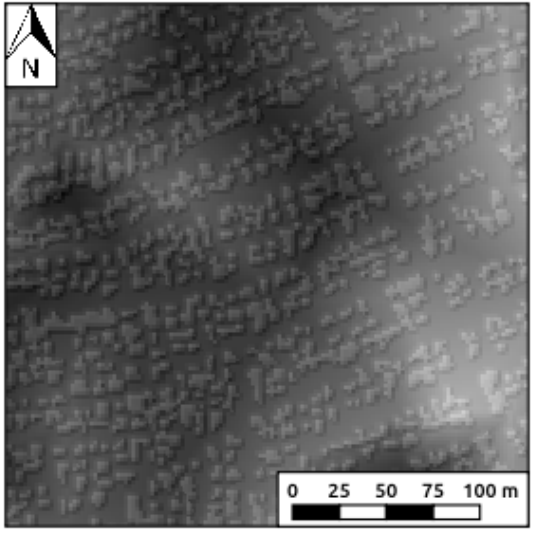
Figure 3. Visualization of the 2m DSM